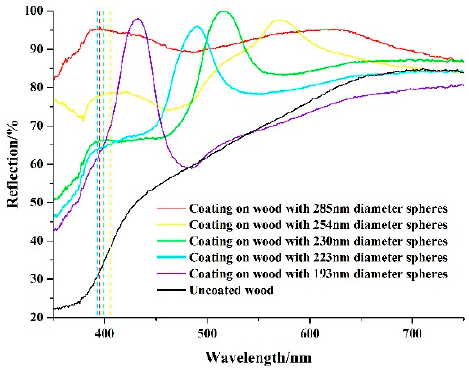
Figure 9. UV-Vis spectra of the coatings prepared using spheres of different diameters.